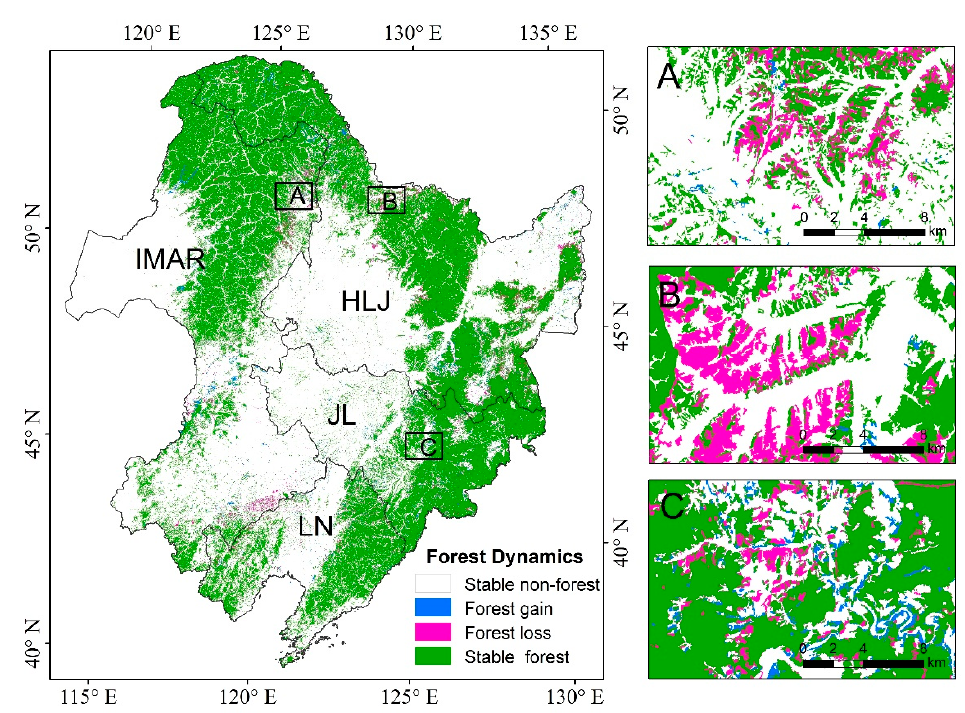
Figure 5. Spatial distribution of forest and its changes during 1990–2015 in northeast China.